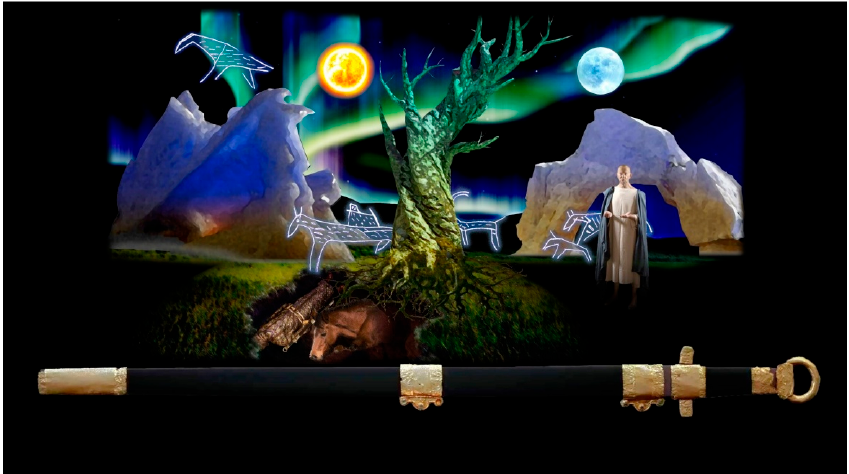
Figure 14. Kunàgota sword, third chapter. Dramatization of the Afterlife, with the shaman vision of the tree of life and the blue sky of